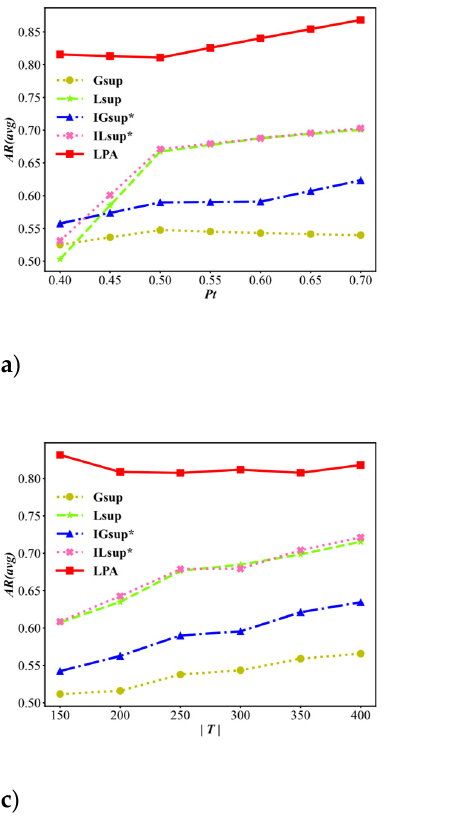
Figure 8. Average location appearance ratio AR ( avg ) (higher is better). ( a ) Varying P t . ( b ) Varying | t | (avg). ( c ) Varying | T | .